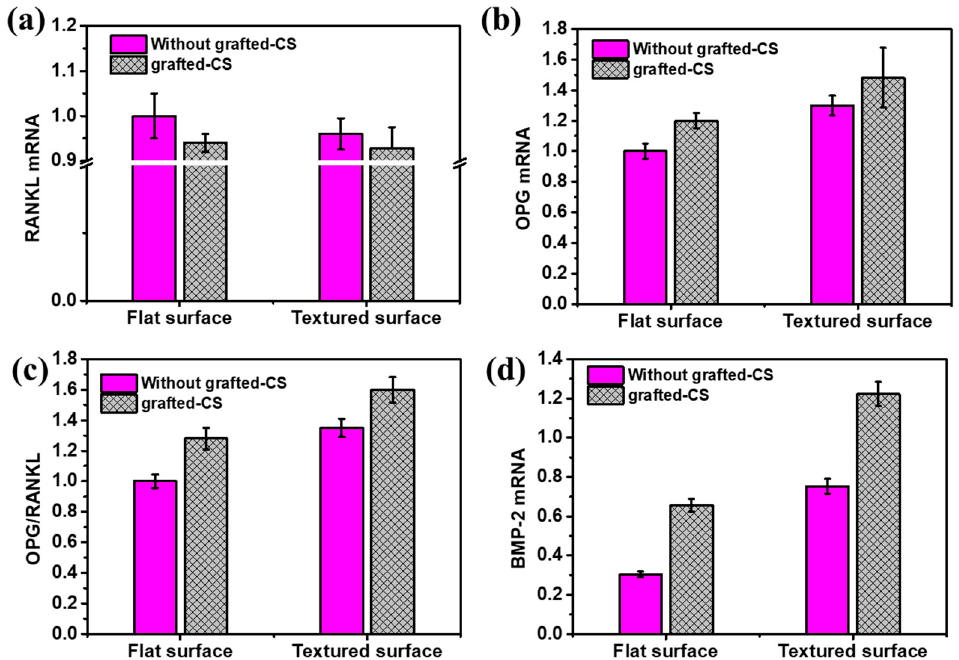
Figure 11. Osteoblast gene expression: ( a ) RANKL mRNA, ( b ) OPG mRNA, ( c ) OPG / RANKL, and ( d ) BMP-2 mRNA.